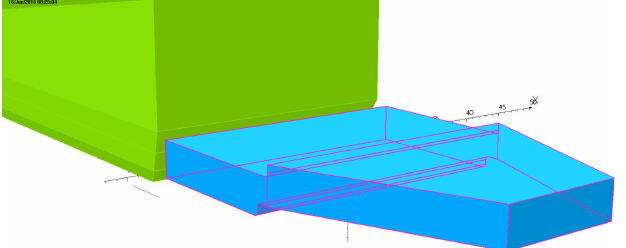
100 model variations. The plate separation was set to accommodate flanges matching the bonnet flanges on VAT all-metal vacuum gate valves used in the Hall C Compton chicane. A flange width of 70 mm was used in that polarimeter and assumed in our design for this option. The iteration process required many plots like those in Figs. 2 and 6. One wants ∼ 30 kG-cm of bending with as uniform and low a field as possible at the D2 exit and D3 entrance regions to soften the synchrotron radiation spec- trum within the aperture of the Compton photon detector. The stepped-taper plate design, Class RS, is closest to this ideal, extending significant field strength more than 25 cm. beyond the edge of the magnet (at 50 cm from the center) and having extended “ plateaus ” of 1600 G and 1200 G.